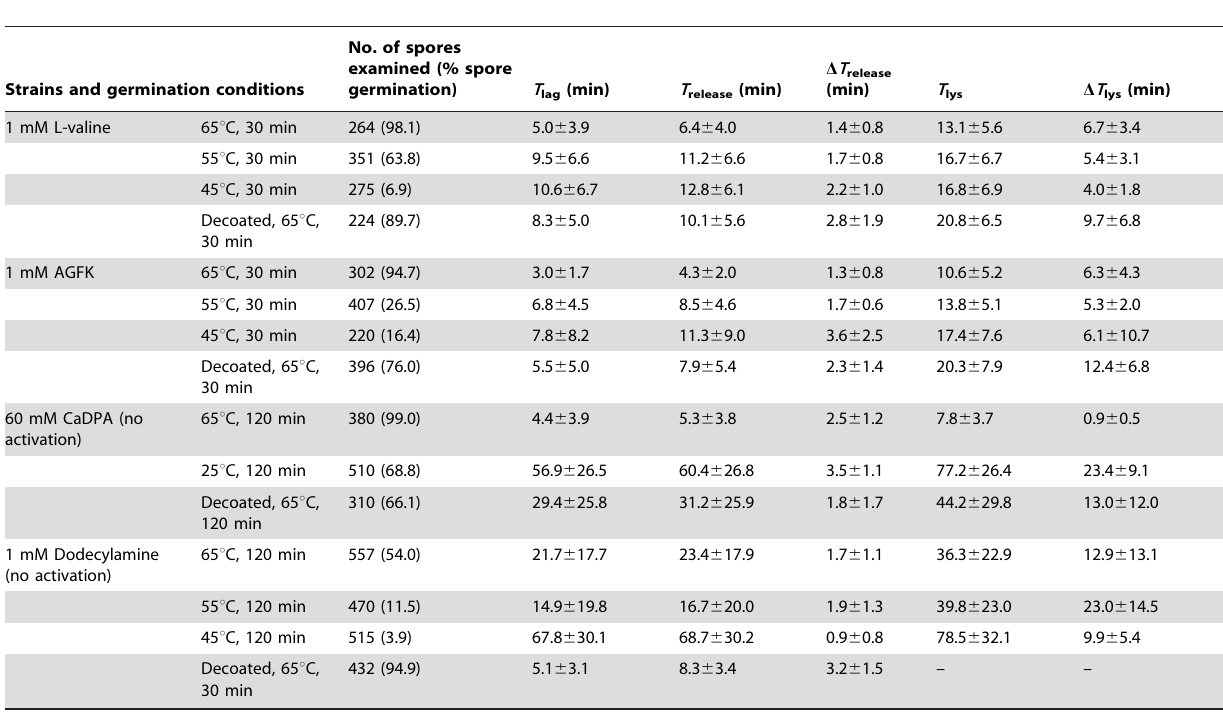
Table 3. Mean values and standard deviations of T lag , T release , D T release , T lys, and D T lys values for individual germinating G. stearothermophilus spores*.